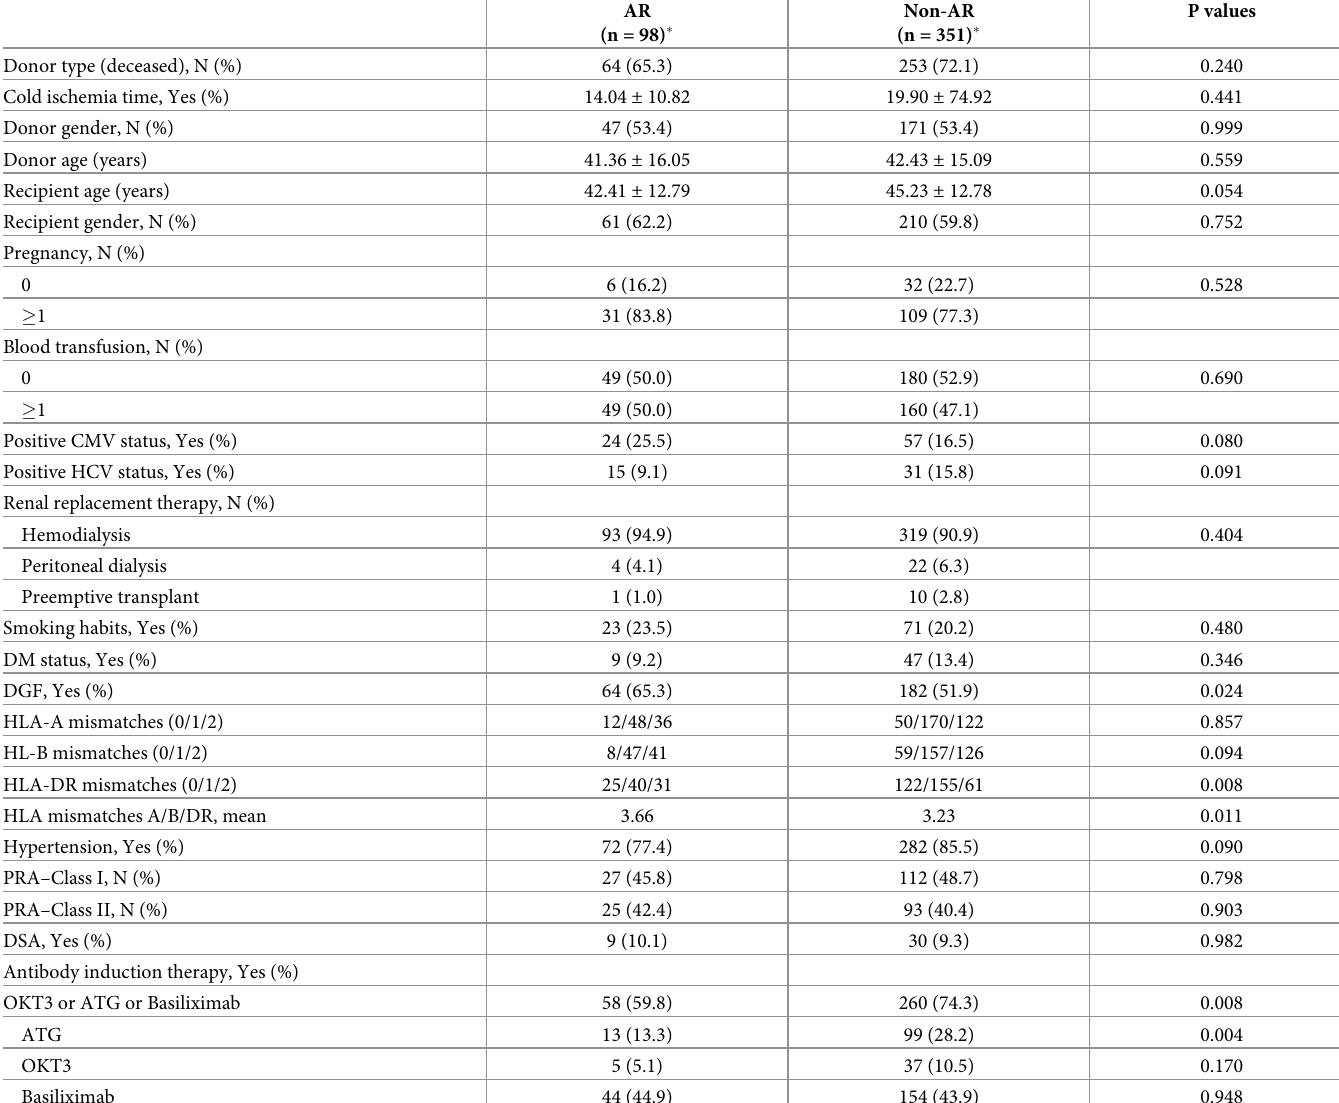
Table 1. Demographic and clinical characteristics of kidney transplant recipients classified by presence kidney acute rejection.